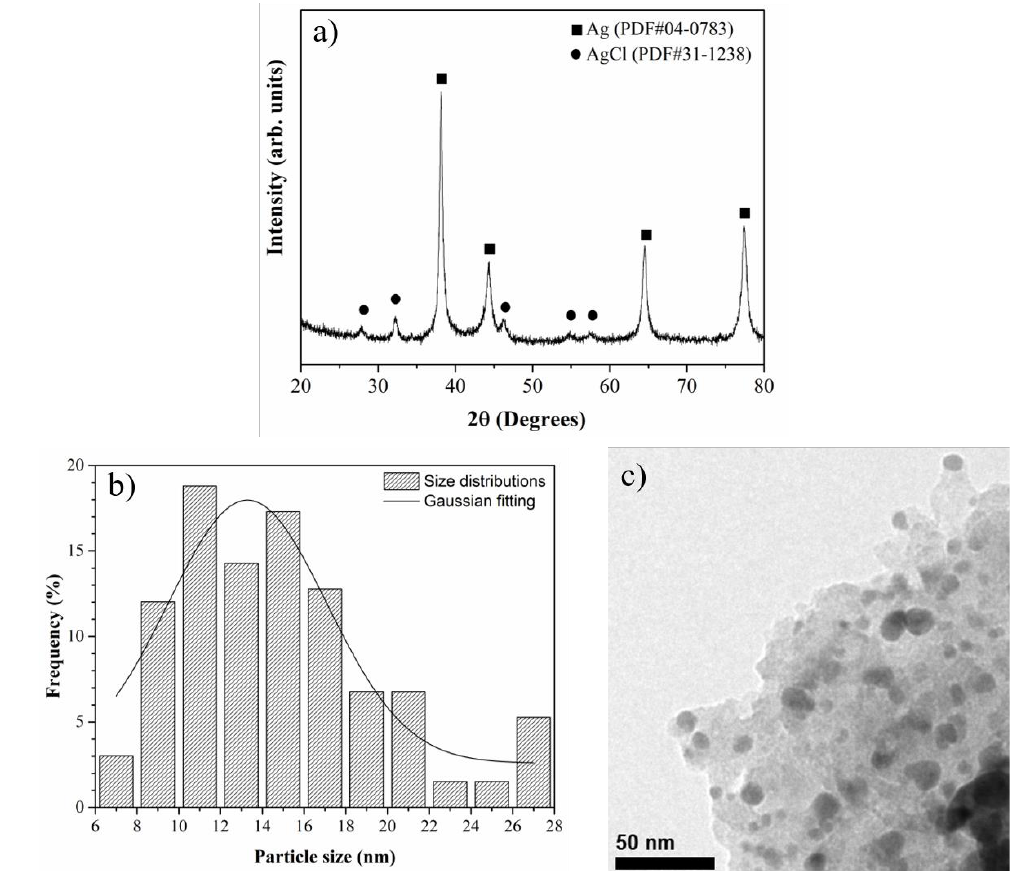
Figure 1. Characterization of AgNP: ( a ) X ray and B ray diffraction patterns, ( b ) micrography obtained in TEM (transmission electron microscopy), ( c ) histogram of AgNP size distribution.